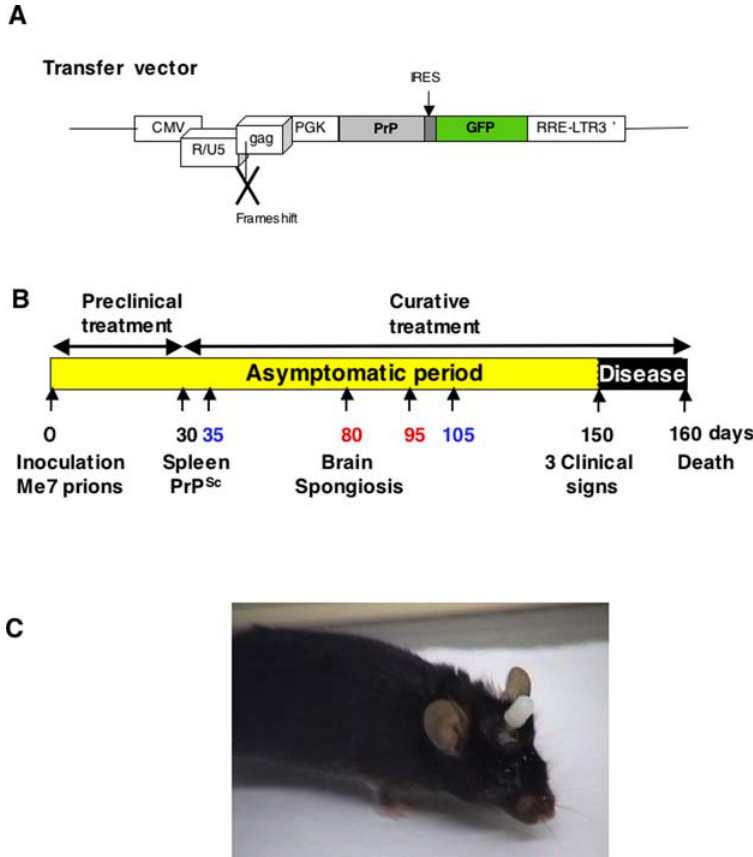
Figure 1. Schematic representation of the transfer vector used for virions preparation (A). The transfer vector was derived from the prototypic FIV-14-Petaluma genome (AIDS Research and Reference Reagent Program) [28]. The U3 region of the 5 9 LTR was replaced with CMV promotor in order to express the vector in the cells. The gag gene was truncated at position 1243 and a frameshift was introduced at position 926. The pol , vif , orfA , env and rev genes were replaced by a cassette containing the mutated PrPQ167R gene driven by the phosphoglycerate kinase promotor (PGK). The PrP gene is followed by an IRES sequence and enhanced GFP gene. As a control vector, we used a transfer vector containing only the GFP gene without the PrP sequence. Schema of the therapeutic protocol assayed in a mouse model of prion disease (B). C57Bl/6 mice inoculated with Me7 prion strain developed a prion disease detectable after 150 days post-infection (p.i.). The prion agent first replicates in the peripheral sites, especially the lymphoreticular system, before the neuroinvasion of the central nervous system (CNS). PrP Sc is detectable in the spleen at 30 days p.i. and the spongiosis is visible in the brain at about 80 days p.i. [34]. Preclinical treatments (1–30 days) target the prion agent during its replication in the lymphoreticular system and before the neuroinvasion of the CNS. Curative treatments (30–160 days) target the infectious agent after the neuroinvasion of the CNS. To evaluate the possible curative effect of Y PrPQ167R, several protocols were tested : ( i ) a unique injection of Y PrPQ167R at 35 or 105 days p.i. (printed in blue); and ( ii ) two administrations of the Y PrPQ167R at 80 and 95 days p.i. (printed in red). Picture of a C57Bl/6 mouse with a guide cannula implanted into its brain (C). An obturator has been fitted into the guide-cannula to prevent the channel from being blocked by tissue